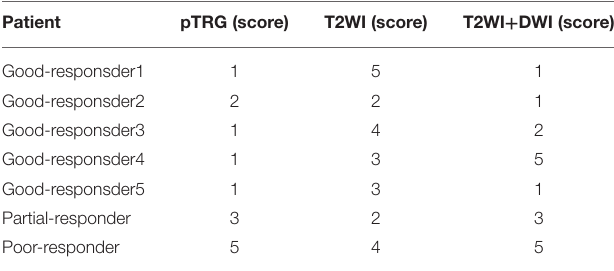
TABLE 2 | Comparision of mrTRG (T2WI or T2WI + DWI) and